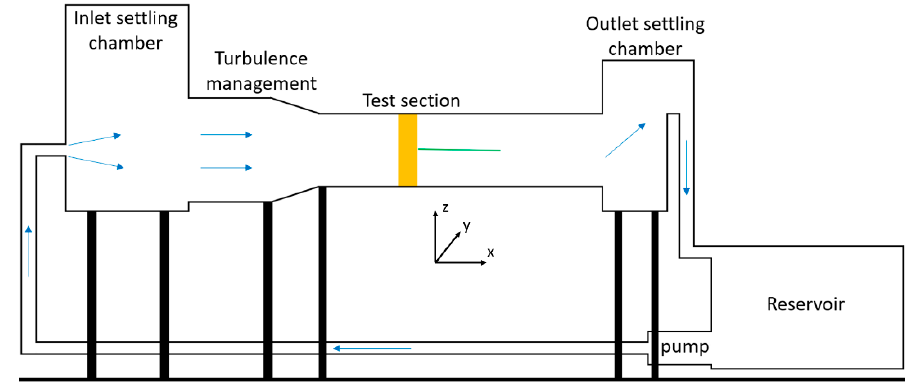
Figure 1. Schematic of LU horizontal water flow tunnel. Indicative measurement plane represented with horizontal green line, downstream of test piece.